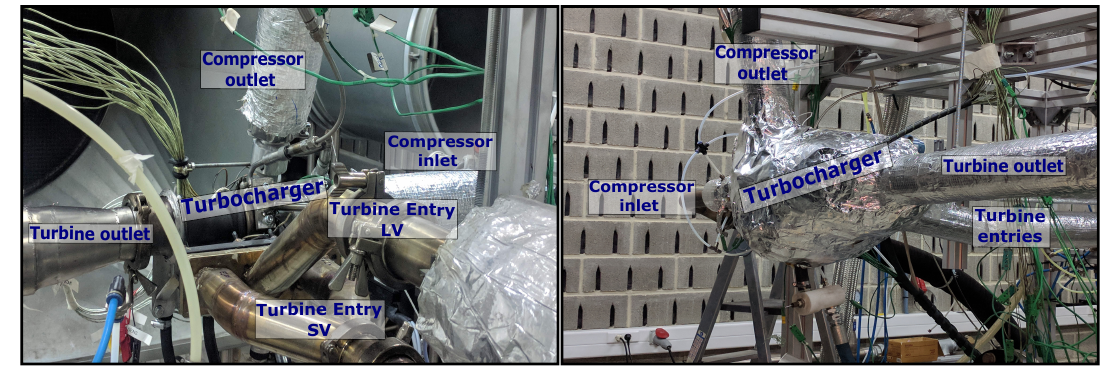
Figure 4. Dual-volute turbocharger setup in the gas